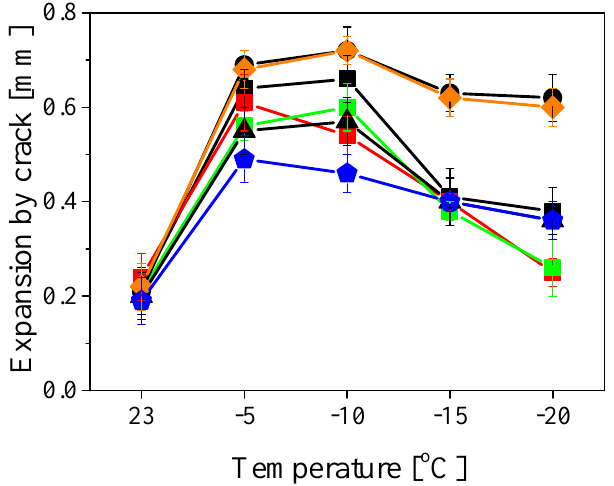
Figure 7. The expansion in millimeters before the membrane cracks at different temperatures for the membranes obtained with the samples a (black squares), b (red squares), c (green squares), d (black circles), e (black triangles), f (orange diamonds) and g (blue